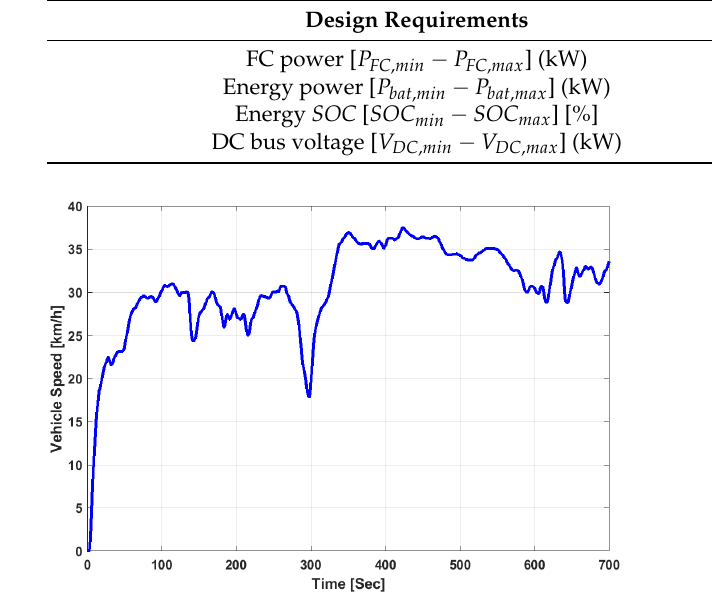
Figure 9. Speed profile of the UDDS standard velocity